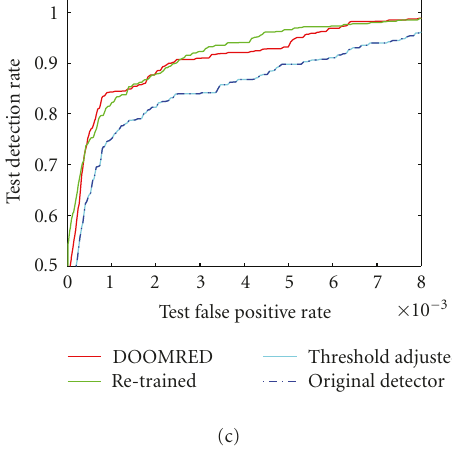
Figure 2: The ROC curves of the single layer detectors when the detector is initially trained with (a) 1000 (b) 2000 (c) 3000 target